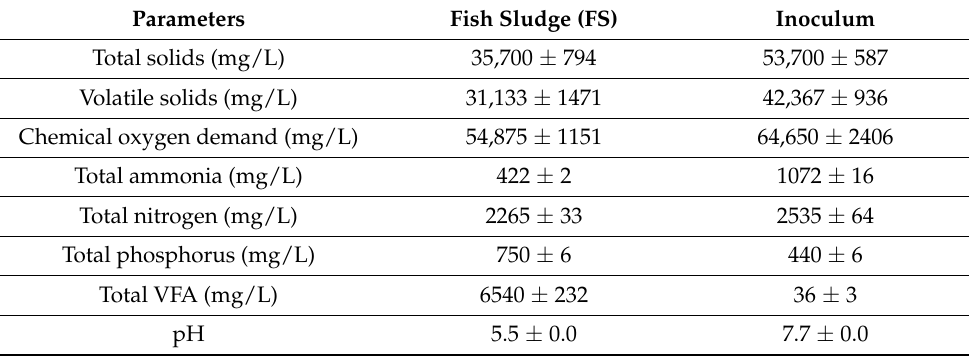
Table 1. Total and volatile solids content, total ammonia, nitrogen, phosphorus, volatile fatty acid (VFA), pH of the substrate (fish sludge), and inoculum used for the experiment (expressed as mean ± std. error).